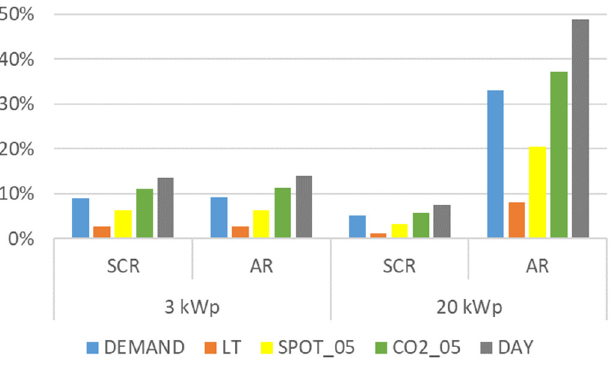
Figure 8. Self-consumption rate ( SCR ) and autarky rate ( AR ) for all penalty signals taking into account the self-consumption based on the yield of a 3 and 20 kWp photovoltaic